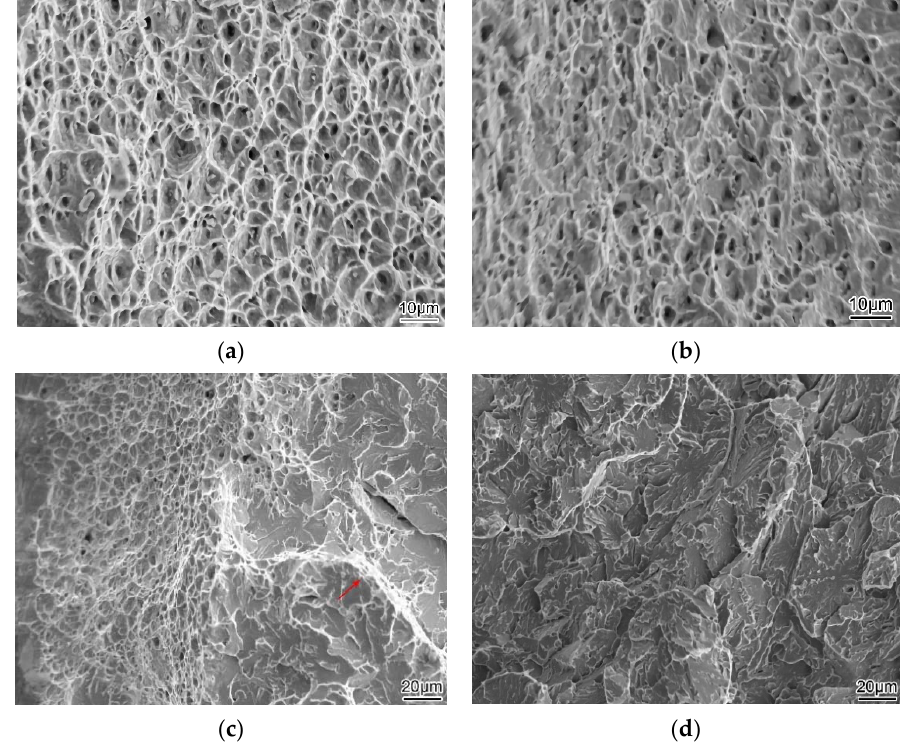
Figure 12. Morphology of impact fracture of weld metal: ( a ) 0.21% Al at 0 °C; ( b ) 1.05% Al at 0 °C; ( c ) 1.05% Al at − 60 °C; ( d ) 1.05% Al at − 60